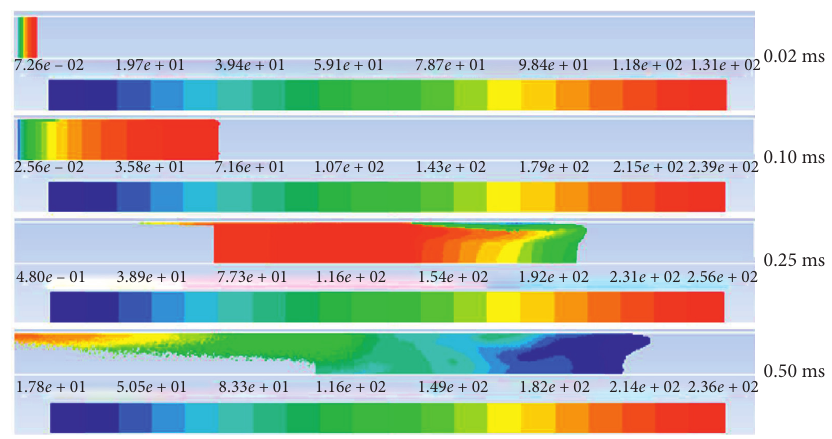
Figure 10: Particle velocity distributions in the driven section.